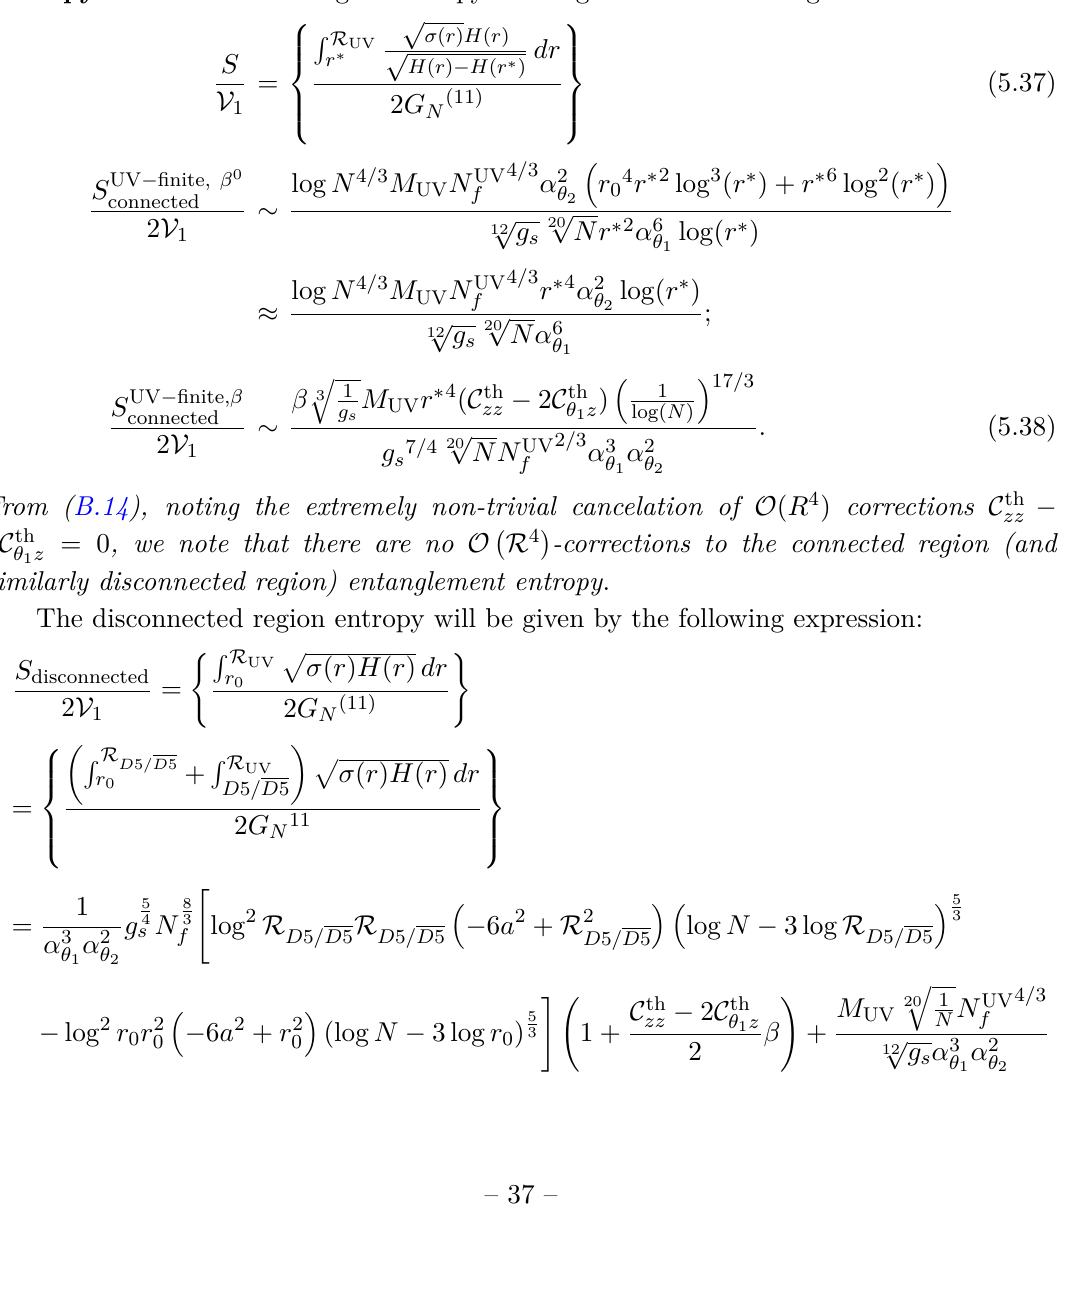
Figure 1 . Plot of r ∗ (log( N ) − 9 log( r ∗ ))(log( N ) − 3 log( r ∗ )) 2 -versus- r ∗ .